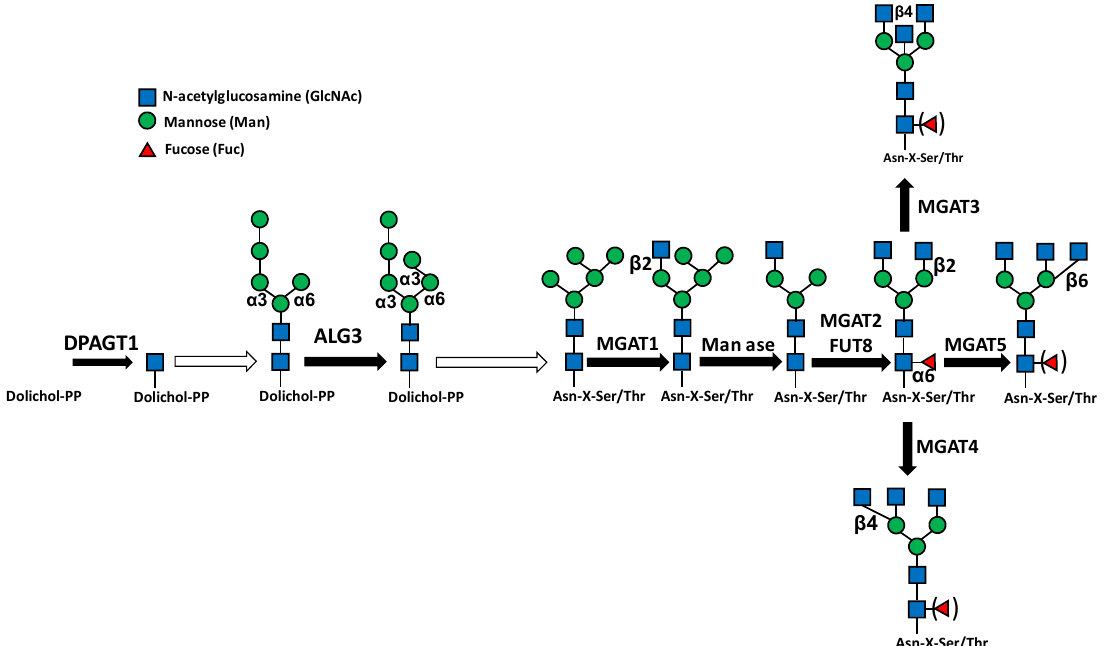
Figure 2. N -glycosylation steps regulated by ncRNAs. Black arrows indicate single-step reactions. White arrows indicate that the indicated transition is the product of multiple steps.